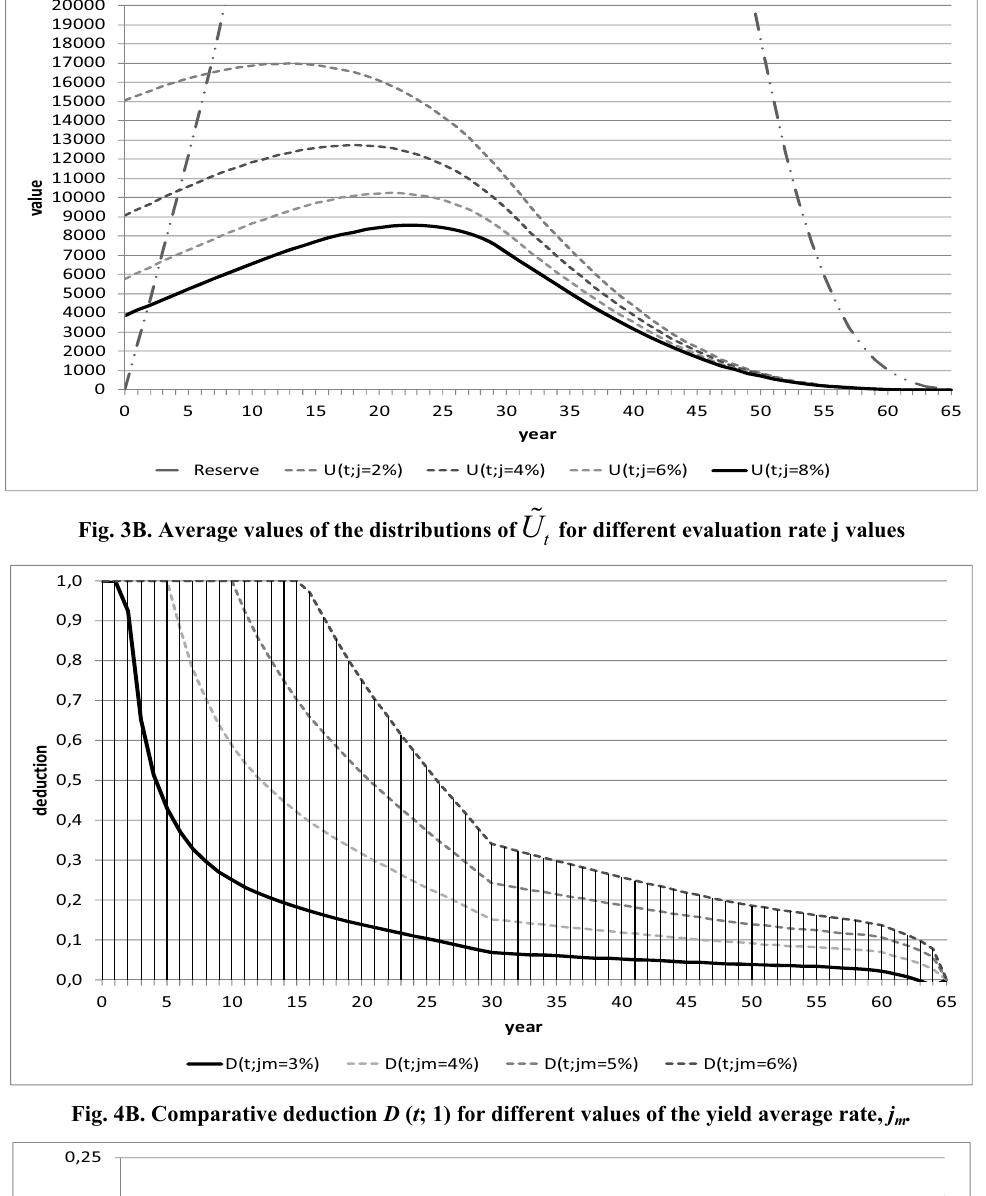
Fig. 4B. Comparative deduction D ( t ; 1) for different values of the yield average rate, j m .